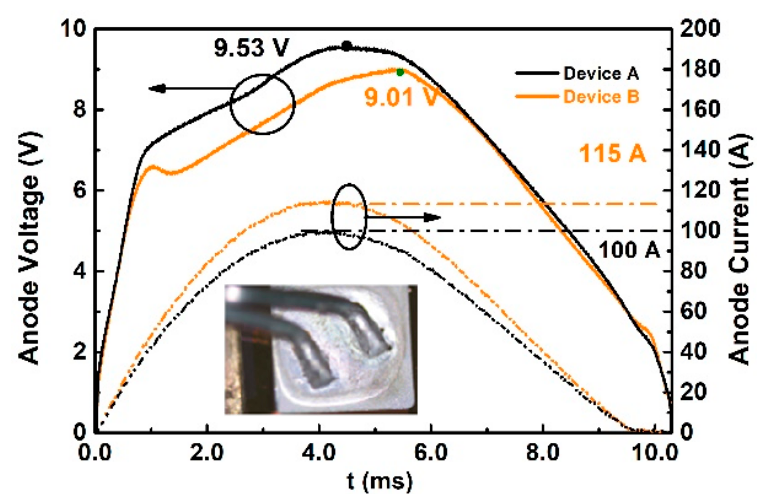
Figure 13. The voltage and current waveforms of Device A and B in the last test before failure.